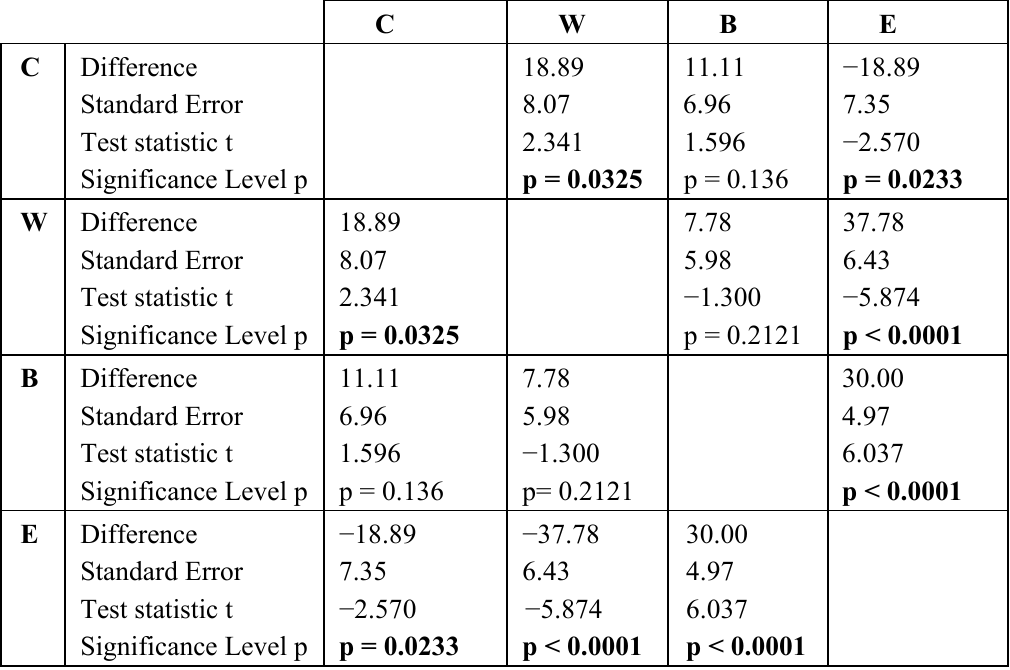
Table 3. Statistical difference between mean discharged current strength values *.